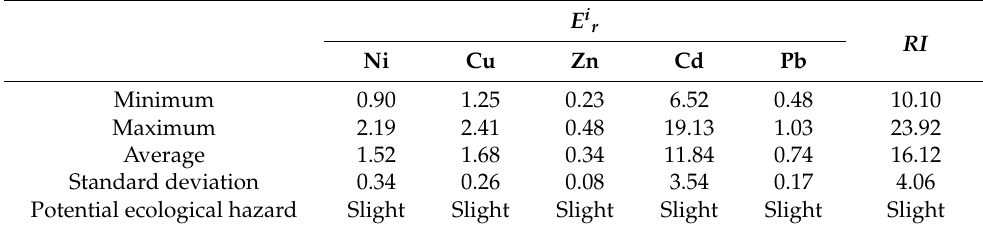
Table 4. Potential ecological hazard index of a single element and comprehensive potential ecological hazard index of heavy metals in the soil.